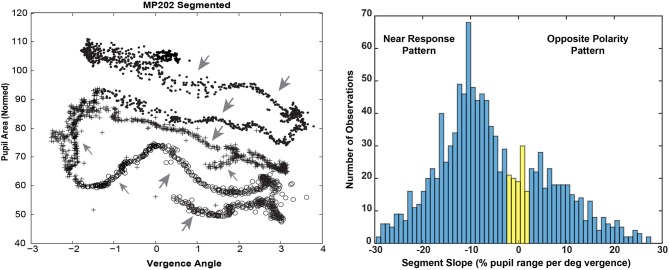
The left panel shows the trajectory of the vergence angle and pupil area for one of the traces shown during the binocular disparity pursuit task in Figure 2B. Note that the graph appears as a series of parallel quasi-linear segments, offset by differences in a pupil size set-point. The right panel shows the bimodal distribution of linear segment slopes. A fuzzy c-means clustering algorithm [(22), MATLAB routine “fcm.m”] indicated that the boundary between two clusters, with at least 0.65 fuzzy class membership (shown in blue), was demarcated by cutoffs of ≤ −2% pupil area range /deg vergence (“near response” pattern) and ≥2% pupil area range /deg vergence (opposite pattern). The intermediate observations (flat slope) are shown in yellow.